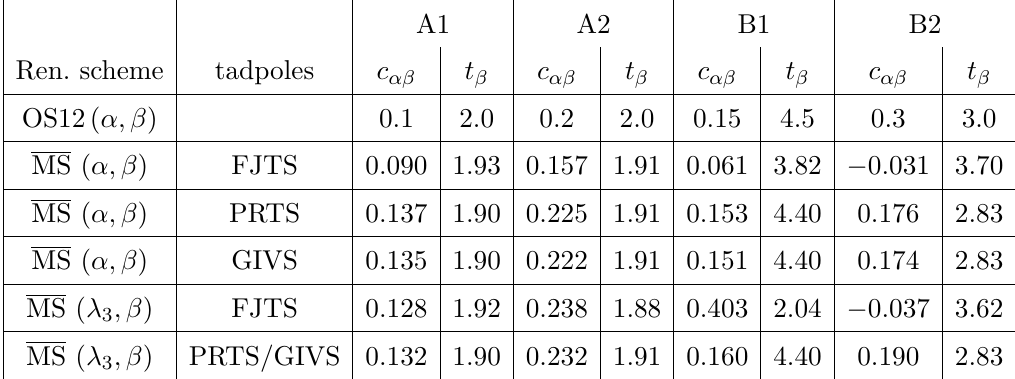
+ 2 M ) / 5 performed in the H ± 0